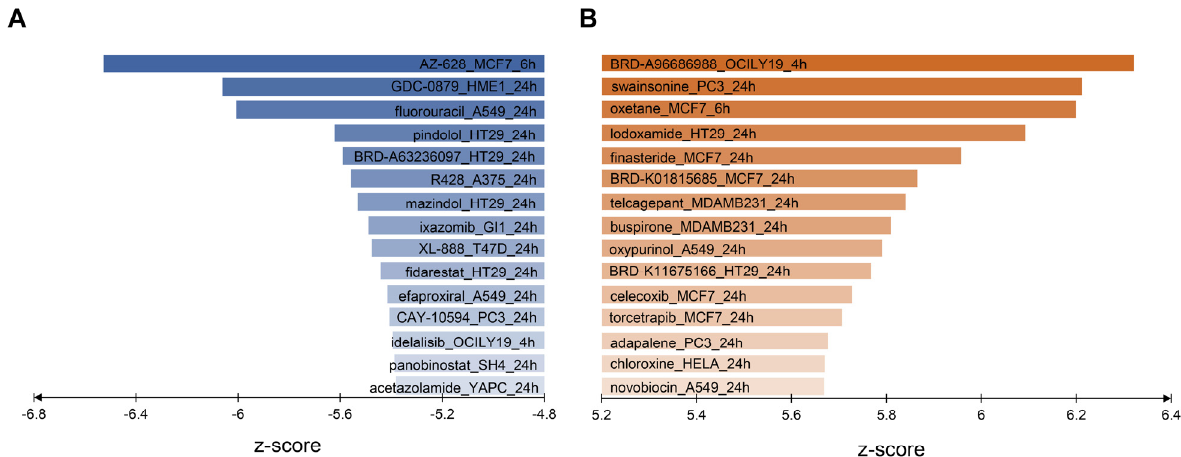
Figure 2. The predicted m6A ‐ targeted drug candidate through Connectivity Map (CMap) analysis. ( A ) Reverser drugs obtained by CMap analysis of consensus DEGs. Each bar label shows the corresponding drug name/code, treated cell line and treatment time. ( B ) Mimicker drugs obtained by CMap analysis of consensus DEGs. Each bar label shows the corresponding drug name/code, treated cell line and treatment time.